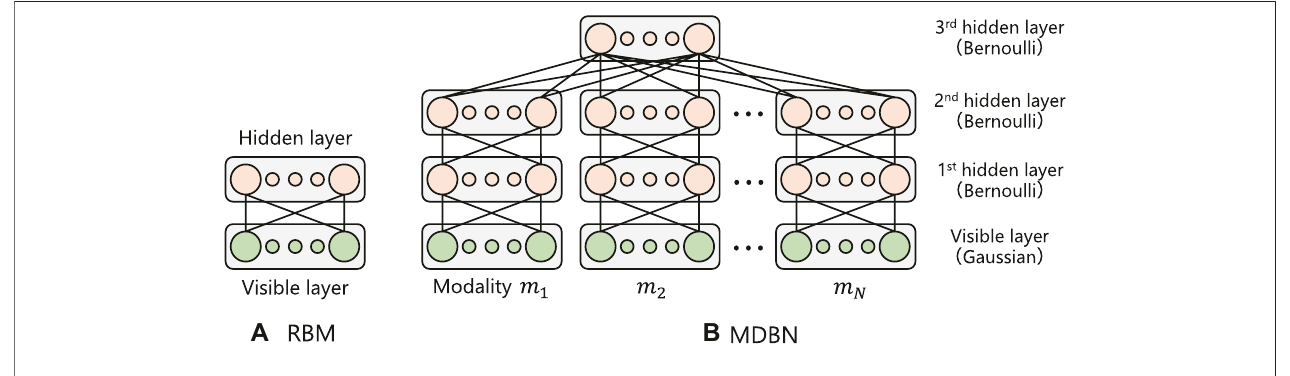
FIGURE 2 | Structures of the RBM, DBN and proposed